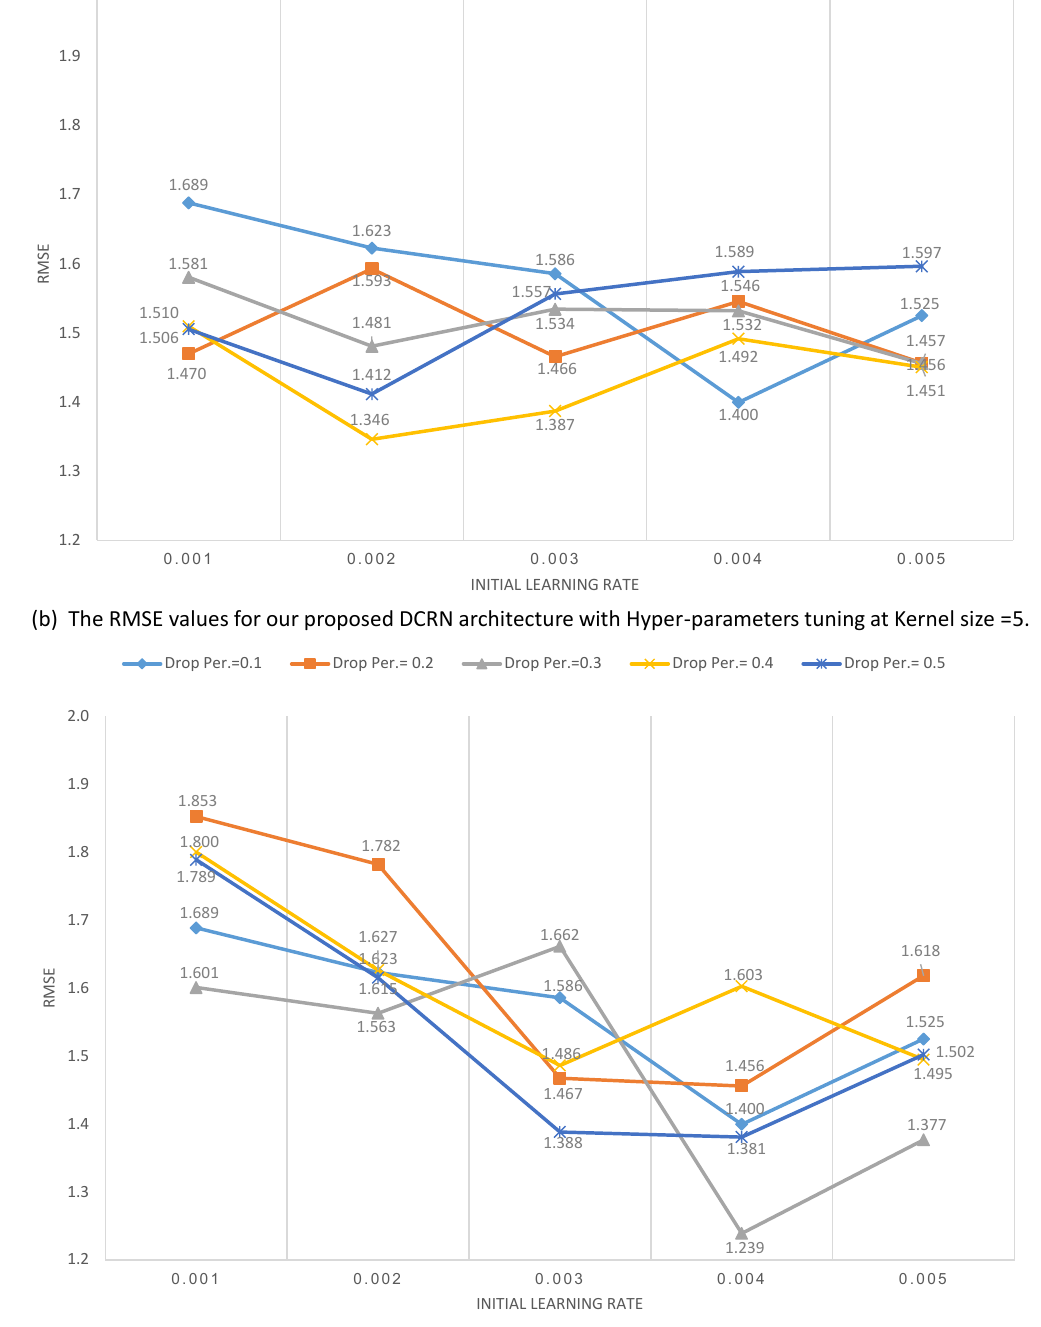
Figure 14. The RMSE values for our proposed DCRN architecture with Hyper-parameters